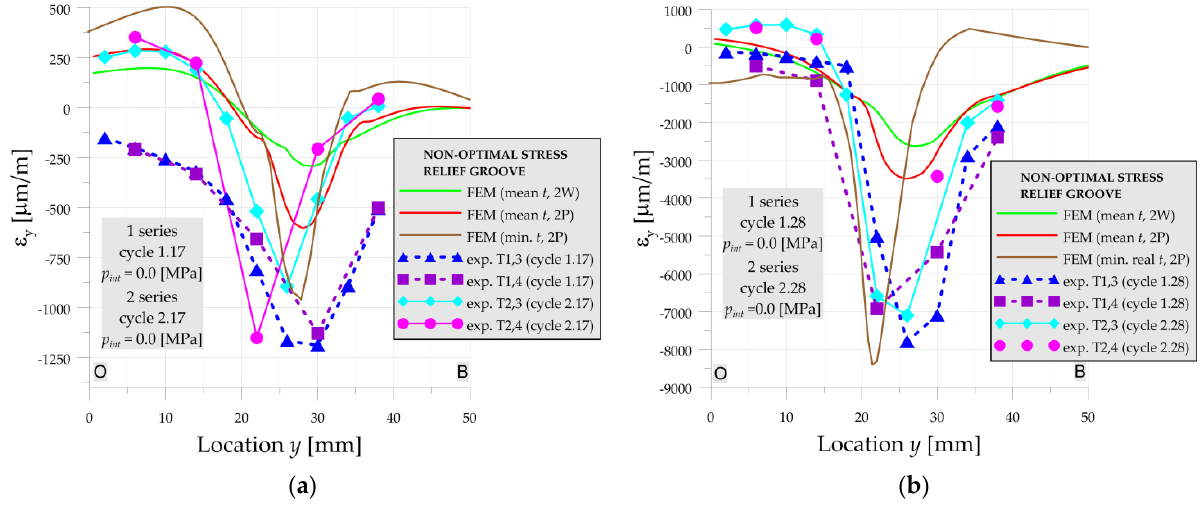
Figure 15. Numerical and experimental strains on line O-B, non-optimal SRG, 1st and 2nd series: ( a ) cycle17; ( b ) cycle 28.